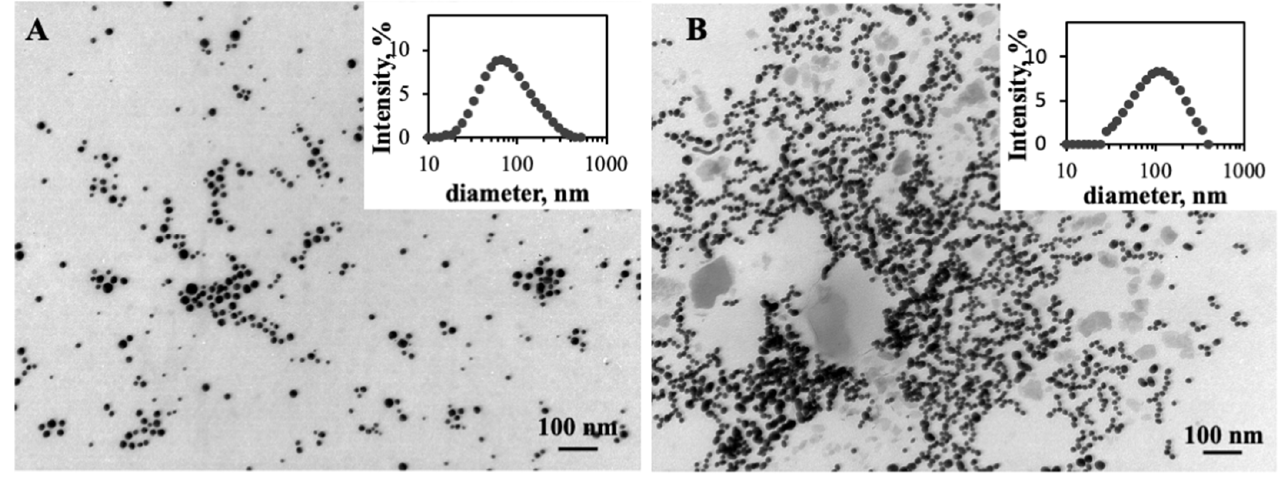
Figure 3. TEM image of: ( A ) EGCG-ChAuNPs; ( B ) EGCG-CystAuNPs. Scale bar is 100 nm.